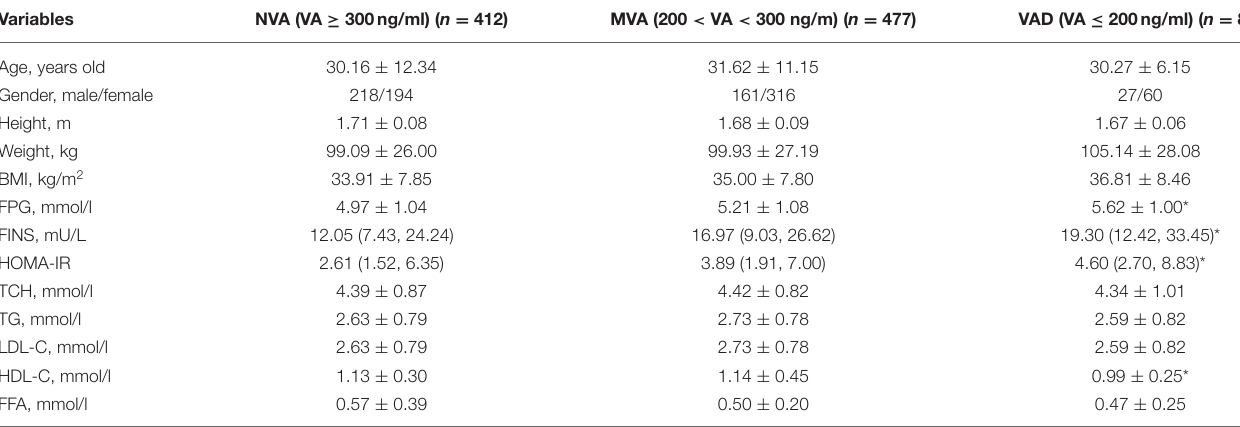
TABLE 1 | Comparison of metabolism among patients with different degree of VA.